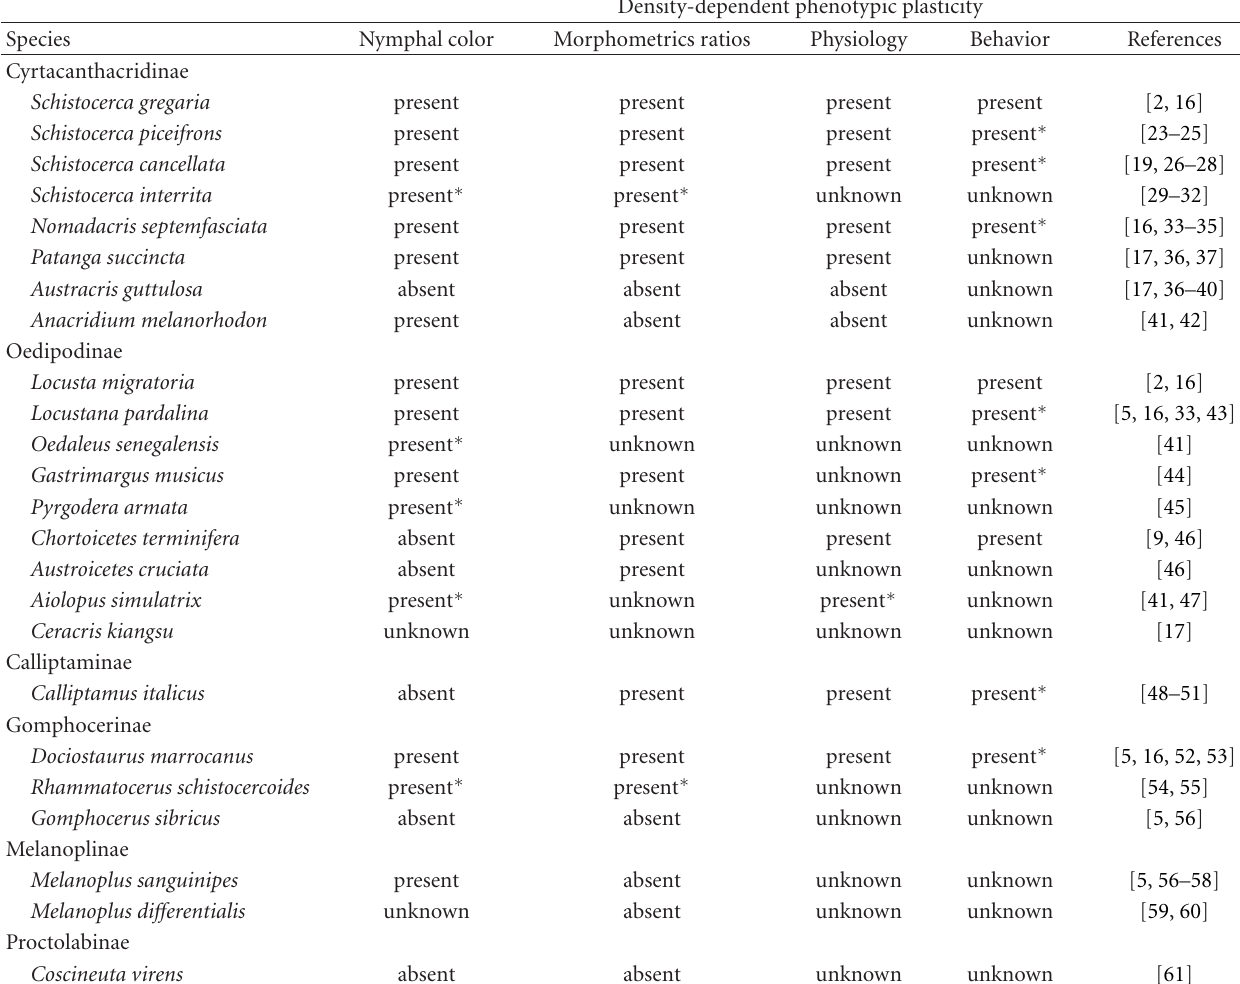
Table 1: Expressions of density-dependent phenotypic plasticity of the species included in this paper. When there is conclusive evidence on presence or absence of density-dependent phenotypic plasticity, it is noted as such. Asterisk denotes the possibility based on inconclusive and anecdotal evidence. Unknown denotes the lack of quantitative